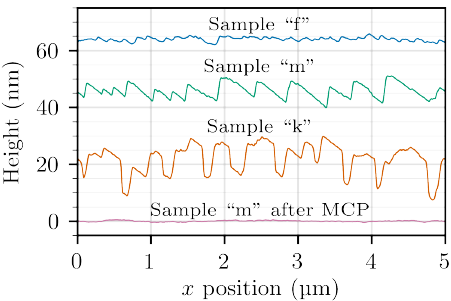
Figure 6. Sections extracted along the dashed lines from the scans shown in Figure 5. The lines have been displaced vertically so that they do not overlap each